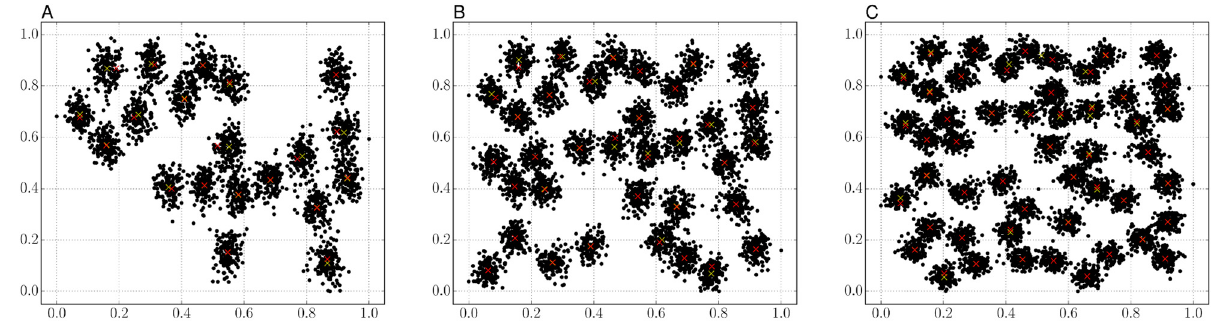
Fig 1. Comparison of the generated mean vectors on the A-sets. (A–C) The positions of the mean vectors generated by the k-means (yellow crosses) and our proposal (red crosses) for A1, A2, and A3 respectively.